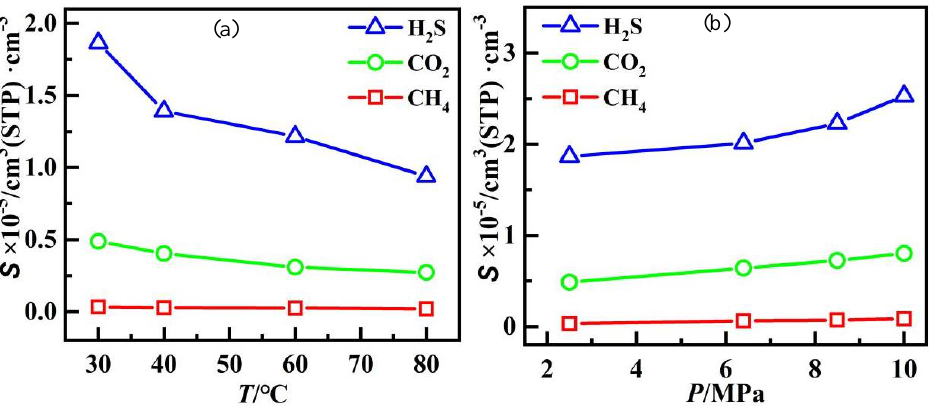
Figure 4. The solubility coefficients of gases at different conditions: ( a ) 2.5MPa; ( b ) 30°C.